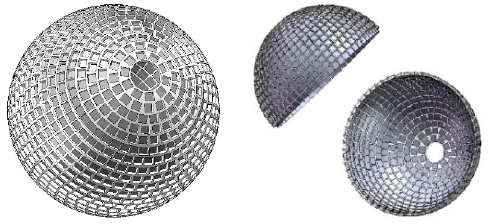
Figure 2. The structure of the powersphere.